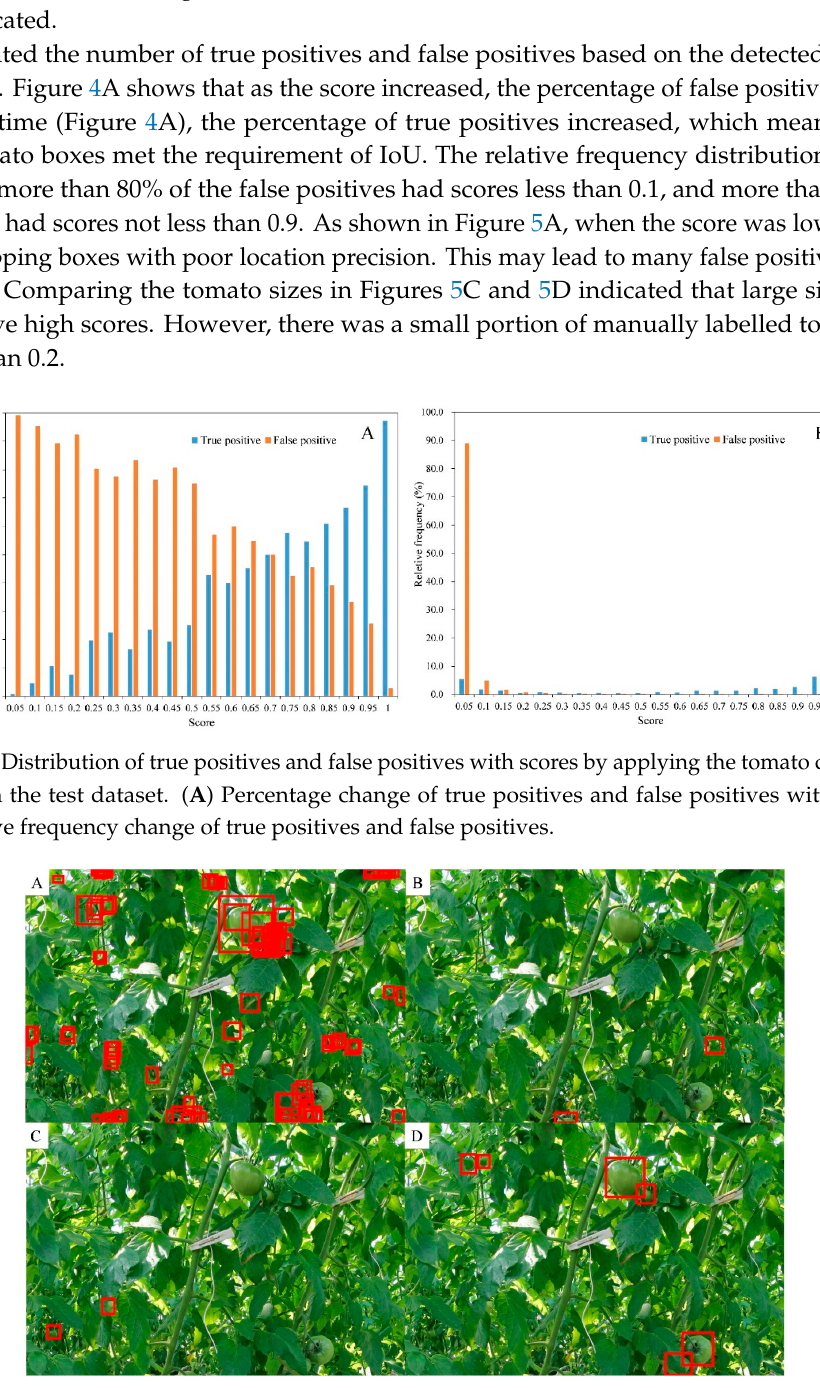
Figure 5. Examples of detected tomatoes with different scores in the test dataset. Subfigure ( A ) shows boxes with scores ≤ 0.3, ( B ) shows boxes with 0.3 < scores ≤ 0.5, ( C ) shows boxes with 0.5 < scores < 0.7, and ( D ) shows boxes with scores > 0.7.